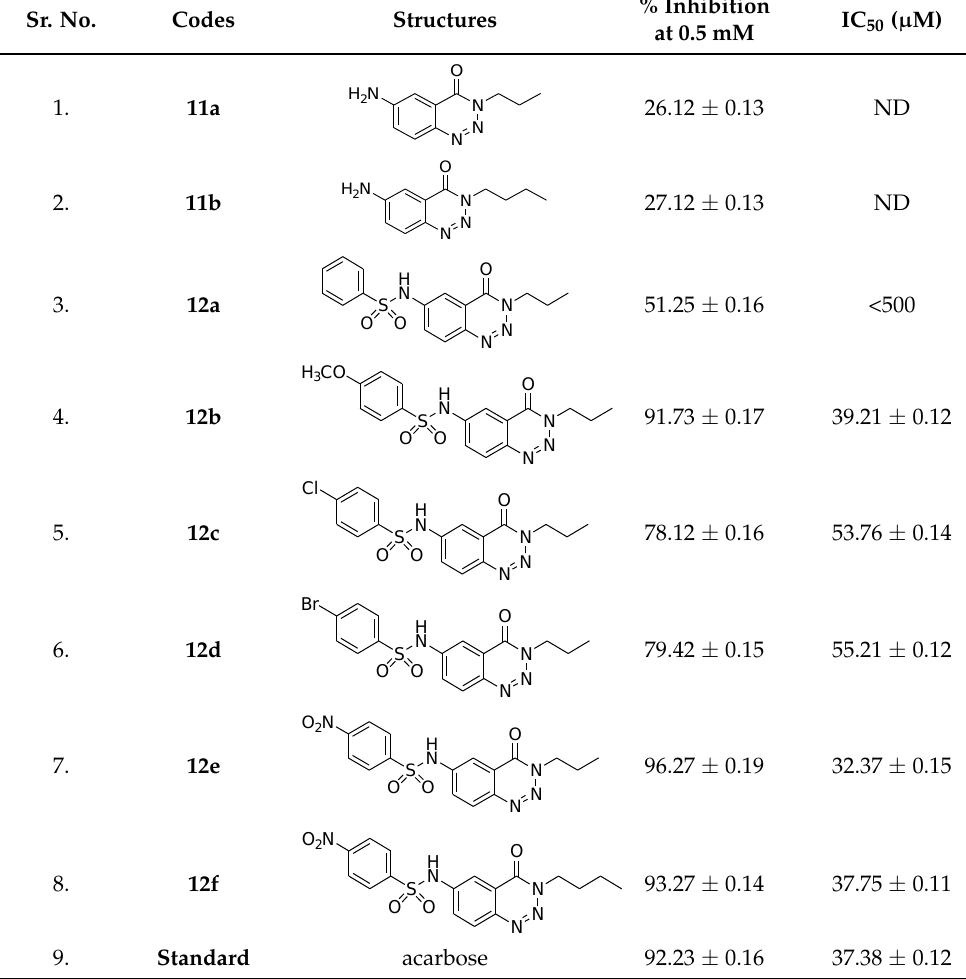
Table 1. Results of alpha-glucosidase inhibition studies. Sr.